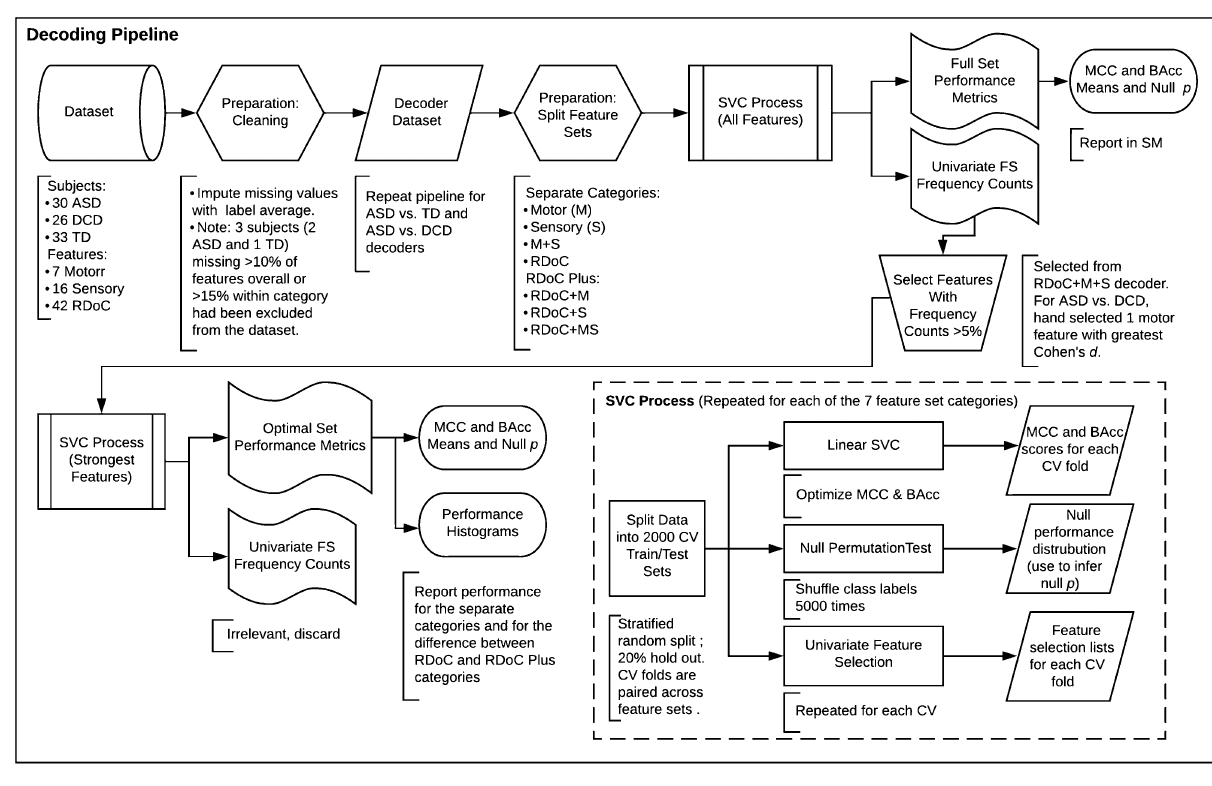
Figure 2. Decoding